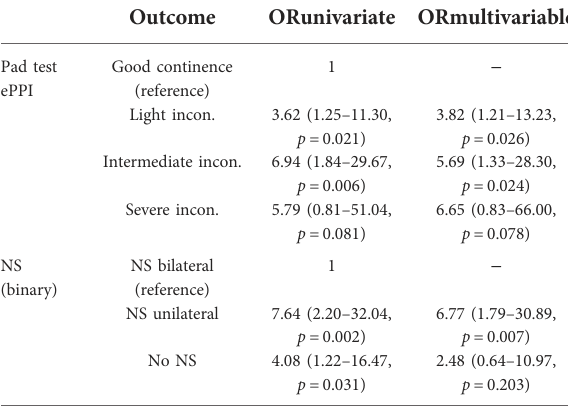
TABLE 5 Univariate and multivariable logistic regression regarding long-term PPI (12 months). Outcome ORunivariate